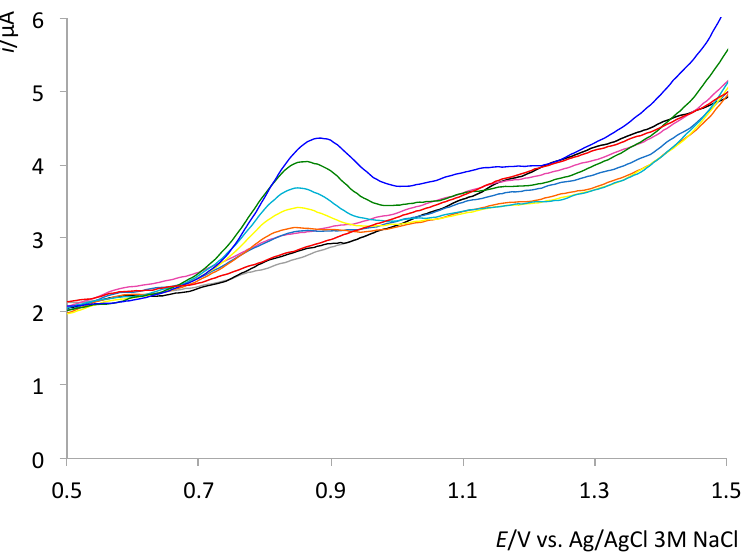
Figure 8. DPV of U-47700 in ethanol/0.1 M lithium perchlorate and 0.10 M 2,6-lutidine; concentration range: from 5 µg·mL − 1 to 150 µg·mL − 1 . Potentials are referred to Ag/AgCl, 3 M NaCl. Scan speed: 50 mV·s − 1 . Working electrode: glassy carbon, 2 mm diameter. Table 4. Calibration curves (DPV) for the considered compounds in ethanol/lithium perchlorate 0.1 M, and associated parameters. Standard deviation is reported after the numerical value. Each curve was obtained with 9 data points, from 5 µ g · mL − 1 to 100 µ g · mL − 1 . Peak potentials observed in DPV are also